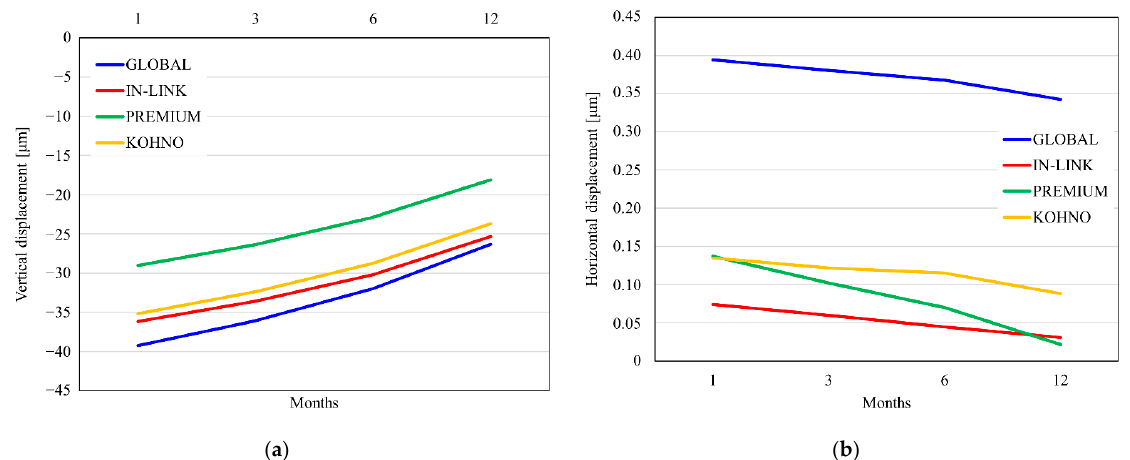
Figure 8. Stability of the implant, assessed by: ( a ) vertical displacement; ( b ) horizontal displacement of the upper node of the implant.